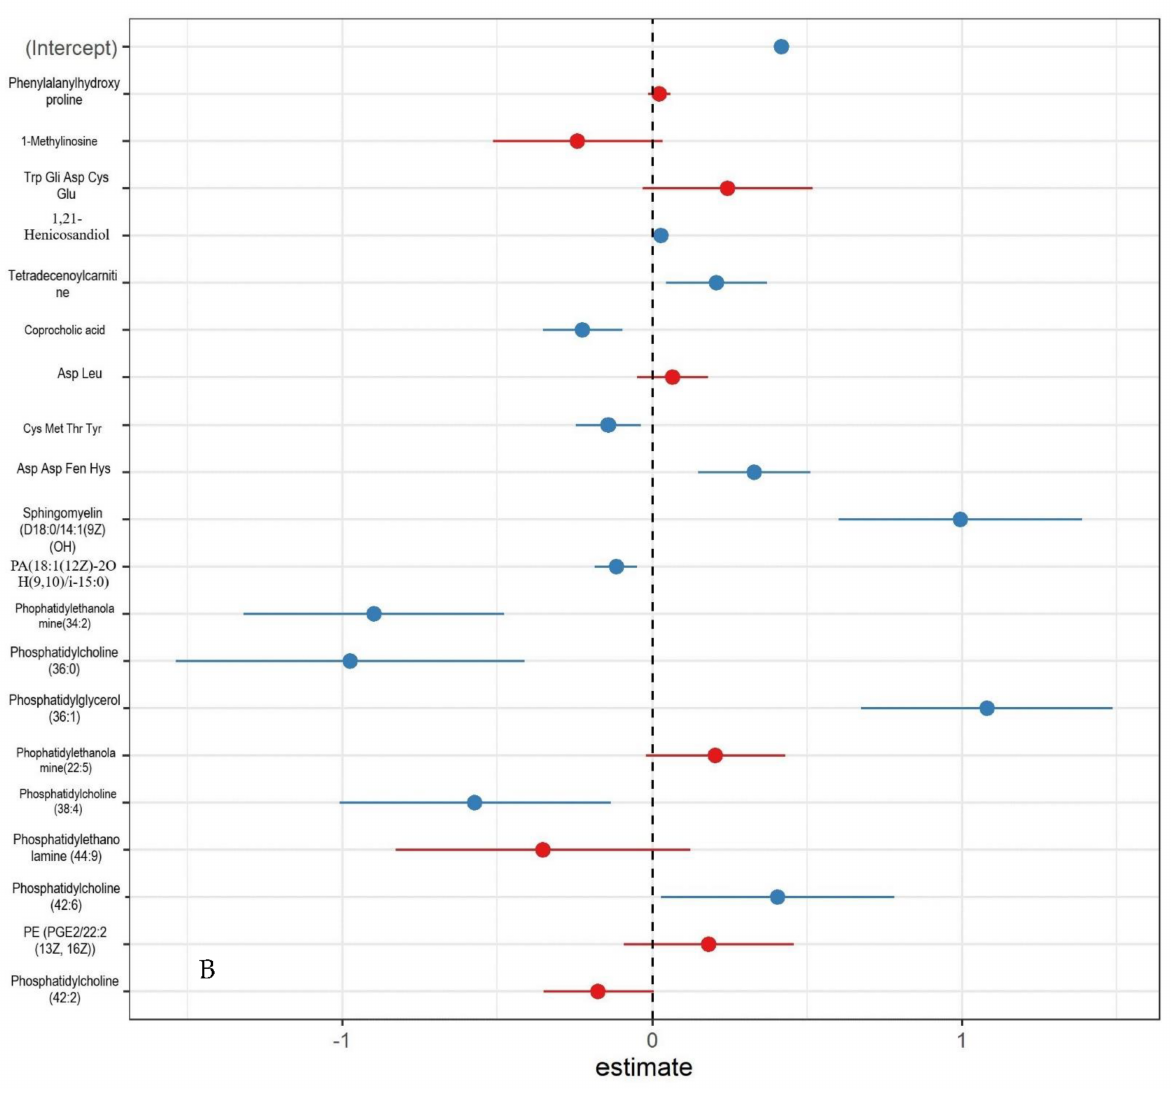
Figure 4. Logistic linear regression results with estimates of β 0 e of β k of discriminating metabolites for MDA and thiol biomarkers. Note: ( A ): MDA; ( B ): THIOL. Note: Coefficients calculated